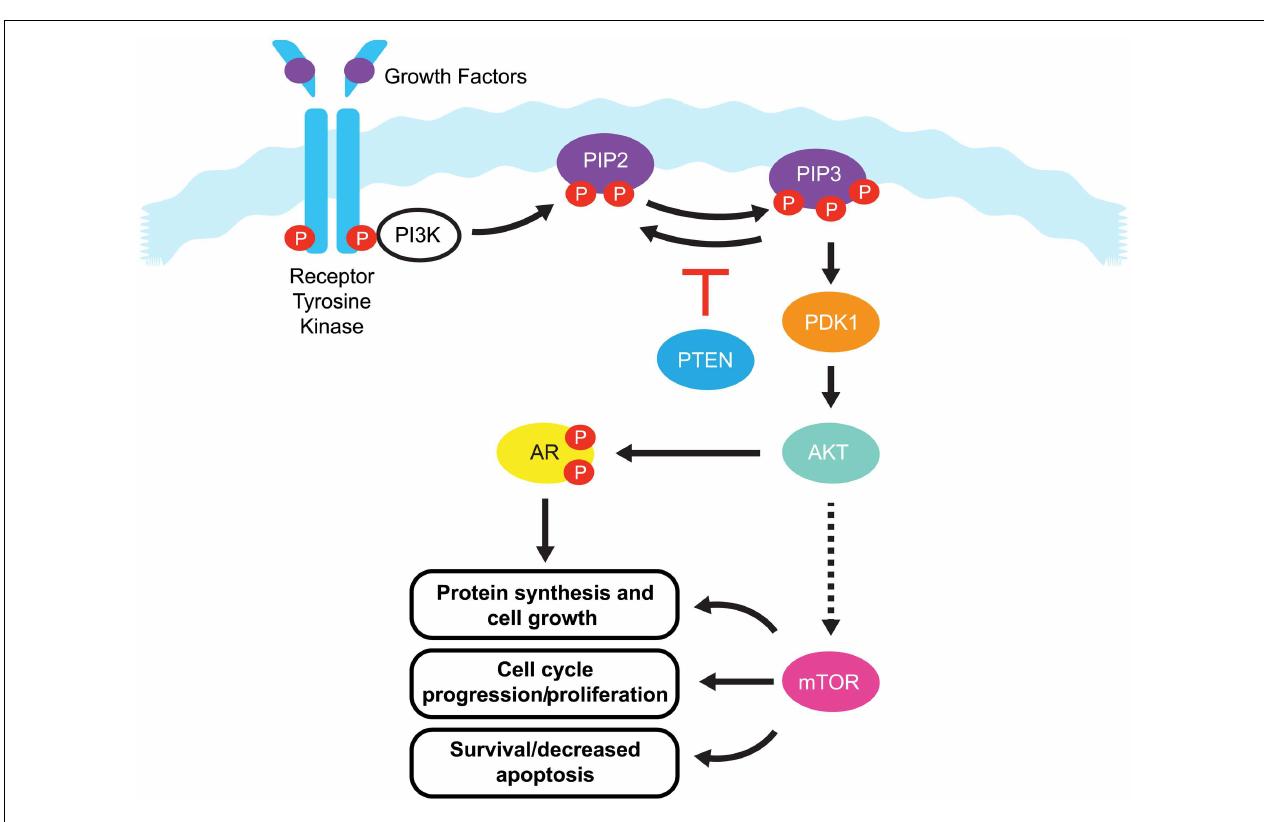
receptor (AR) in an androgen-independent manner, leading to over-activation of the AR signaling pathway in castration resistant prostate cancer. PTEN is a tumor suppressor that negatively regulates the pathway by removing the 3-phosphate from PIP3, converting it back to PIP2. Loss of PTEN leads to over-activation of Akt which, in turn, is associated with uncontrolled cell proliferation, decreased apoptosis, and enhanced tumor